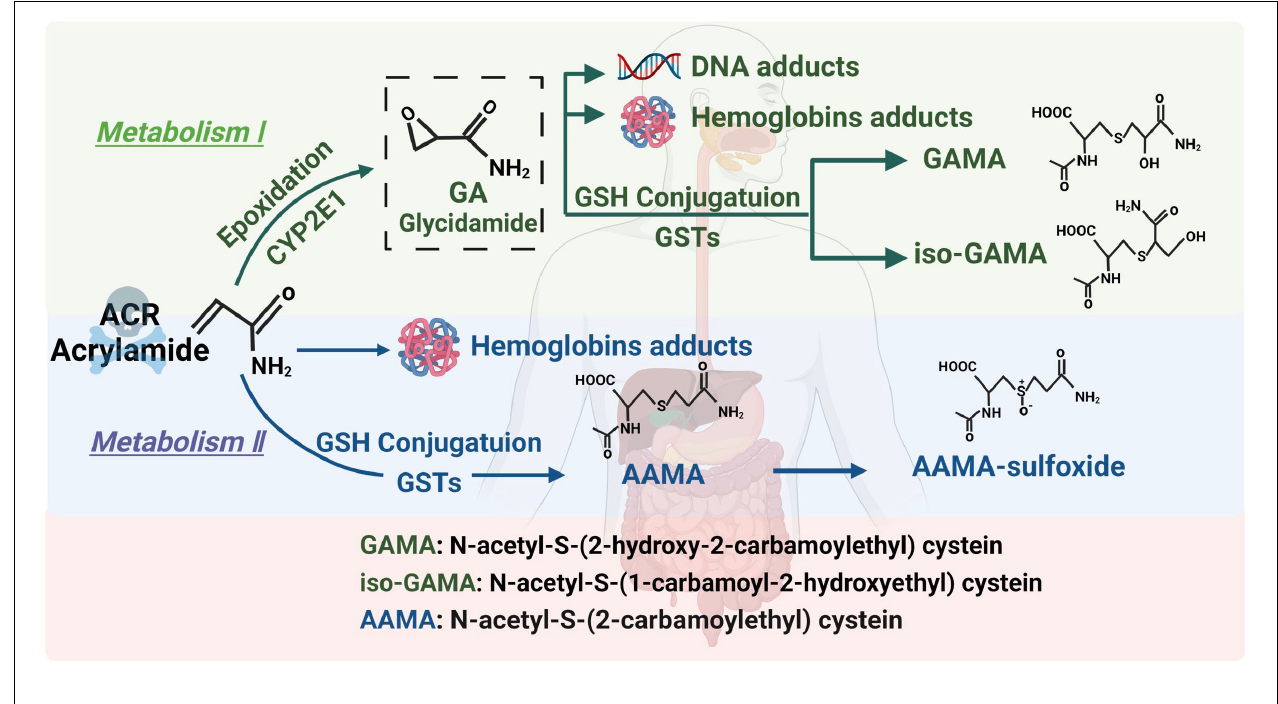
FIGURE 1 | The metabolic pathway of